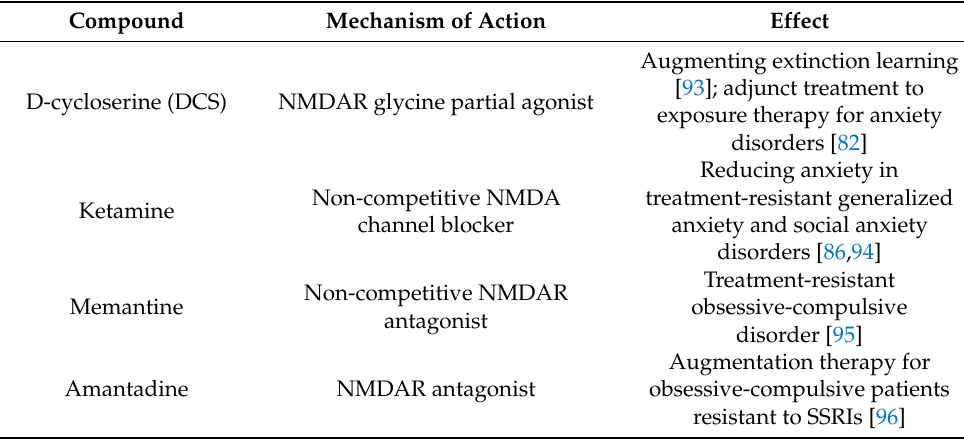
Table 1. Novel NMDARs modulators in clinical trials for